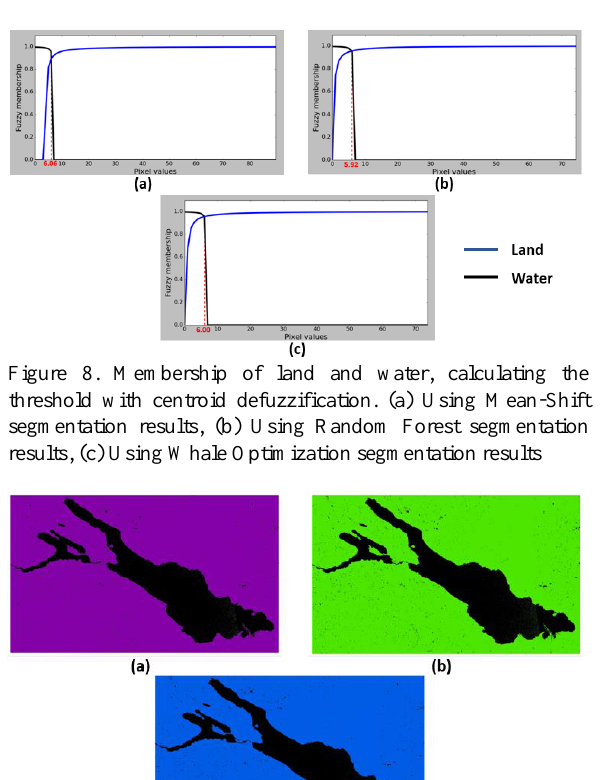
Table 5. Calculated parameters for fuzzy clustering After calculation of the parameters, the defuzzification thresholds have been calculated from Mean-Shift segmentation, Random Forest and Whale Optimization methods as 6.06, 5.92 and 6.0 respectively as given in Figure 8-a, b, c. Segmented images and shoreline extraction results by Mean-Shift segmentation, Random Forest and Whale Optimization methods are given in Figure 9-a, b, c and Figure 10-a, b, c respectively.